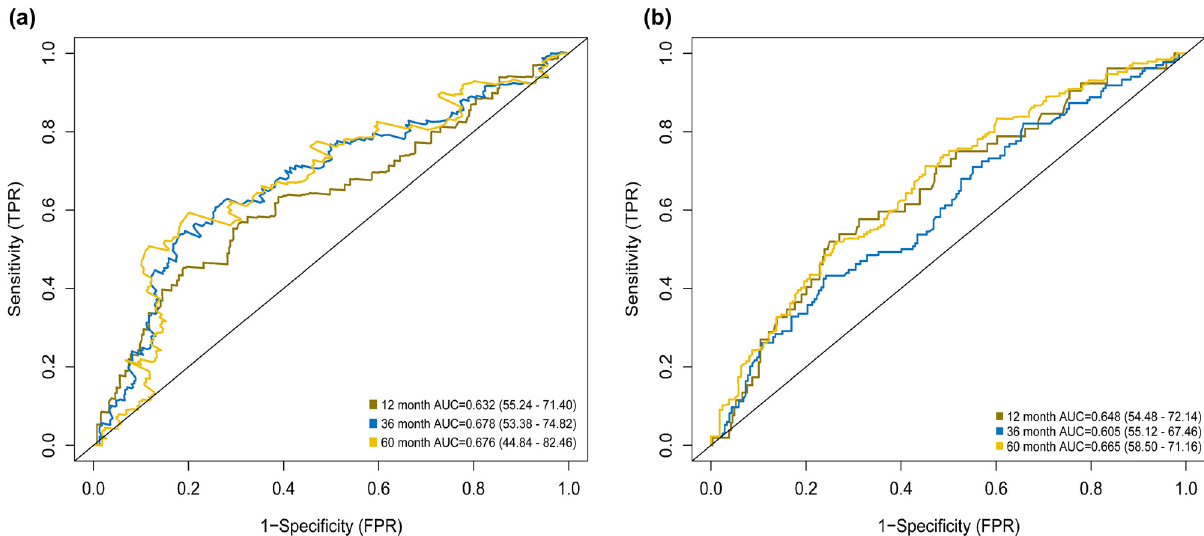
Figure 3: Time - dependent ROC curves of OS for the nine immune - relevant genes ’ signature score. ( a ) TCGA cohort and ( b ) GSE84437 cohort at 1 - , 3 - , and 5 years.